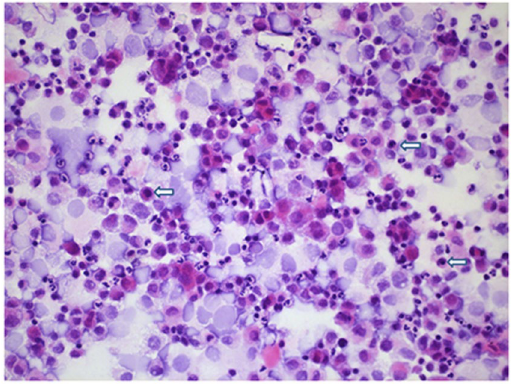
Figure 2. Apoptosis of cumulus granulosa cells (HE staining, × 100). The arrows indicate pyknosis of cumulus granulosa